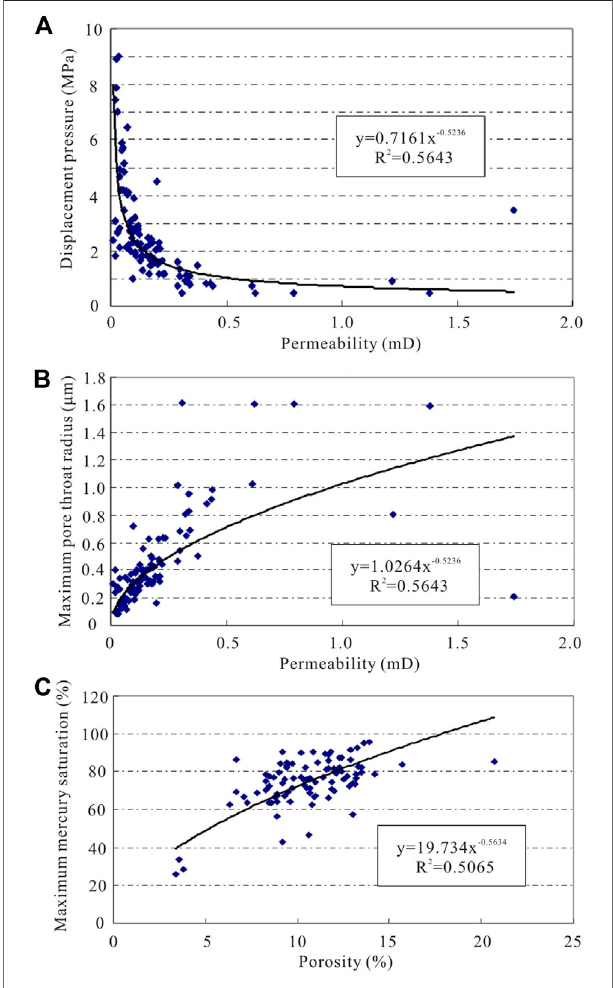
FIGURE 6 | Relationship between petrophysical property parameters and pore structure parameters. (A) Relationship between displacement pressure and permeability; (B) Relationship between maximum pore-throat radius and permeability; (C) Relationship between maximum mercury saturation and